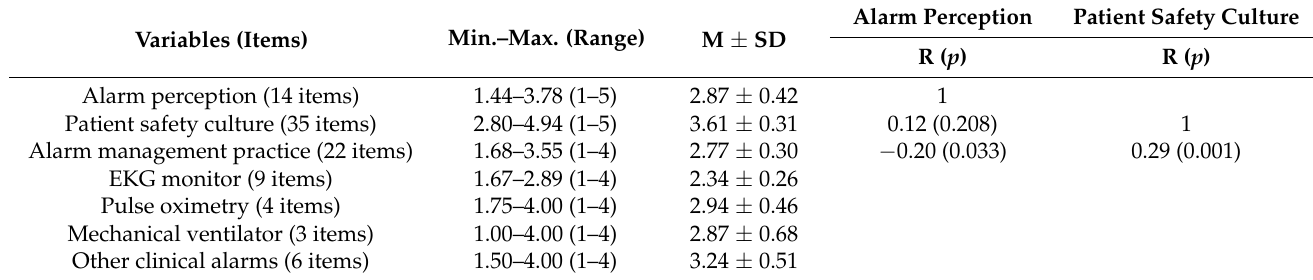
Table 3. Description and correlation among alarm perception, patient safety culture, and alarm management practice (N = 116). Variables